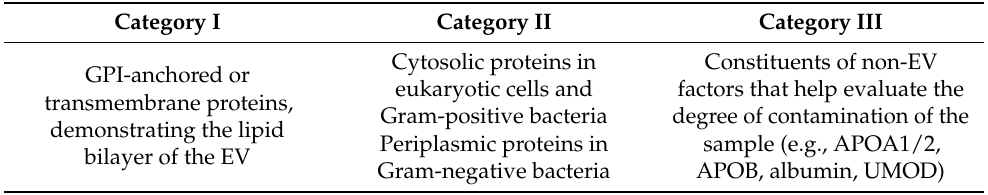
Table 1. Markers that confirm the presence of EVs.